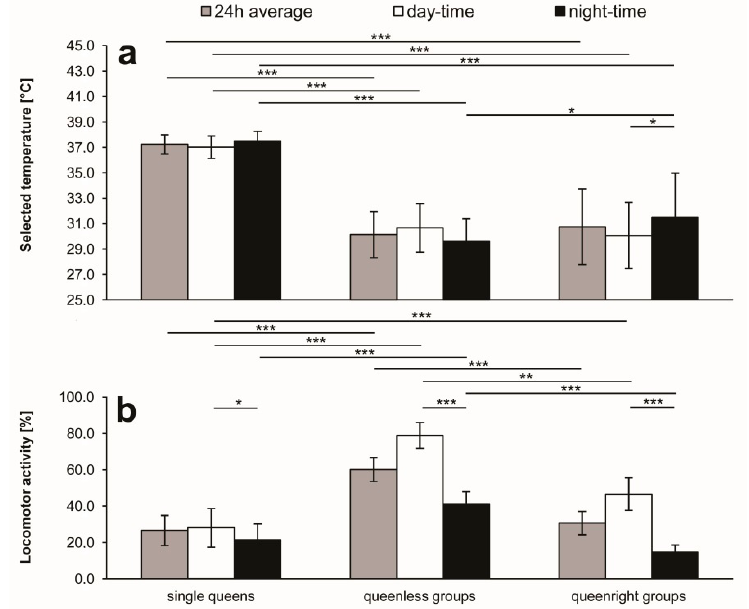
Figure 2. The 24-h, daytime, and nighttime averages ( ± SD) of ambient temperature preference ( a ) and locomotor activity ( b ) of single queens and queenless as well as queenright groups of worker honeybees. Asterisks indicate the statistical significance of di ff erences between means: * p < 0.05, ** p < 0.01, *** p <